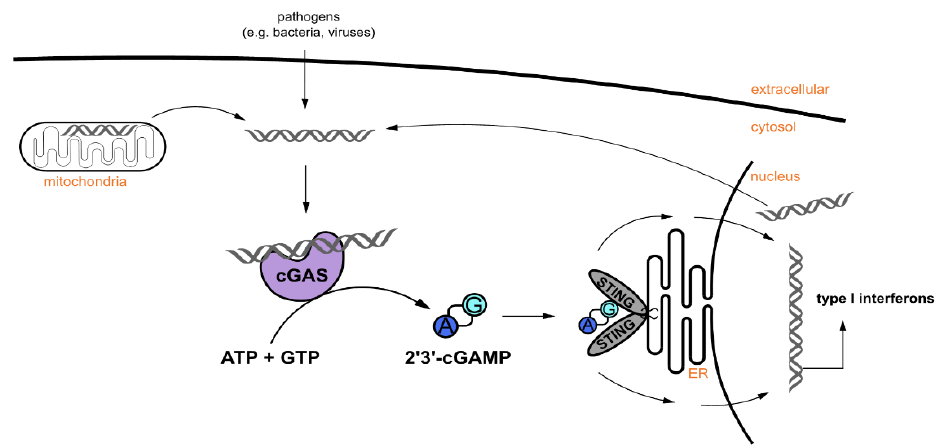
Figure 1. The cyclic GMP-AMP synthase (cGAS) activates the stimulator of interferon genes (STING) pathway. cGAS binds to cytosolic DNA, which can originate from infection with foreign DNA or damaged mitochondria or nuclei. cGAS catalyzes the cyclization of ATP and GTP to cyclic guanosine monophosphate-adenosine monophosphate (2′3′-cGAMP). 2′3′-cGAMP binds to STING that is located at the endoplasmic reticulum (ER) and two cascades are initiated and trigger the transcription of type I interferons.